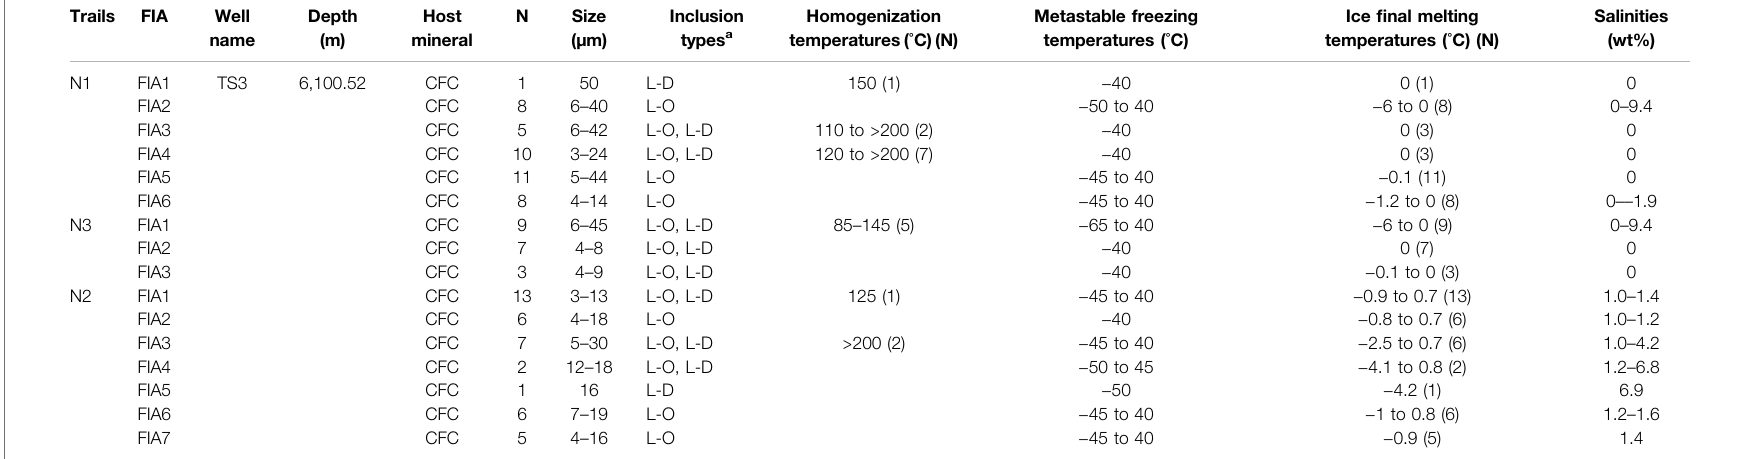
TABLE 1 | Fluid inclusion microthermometric